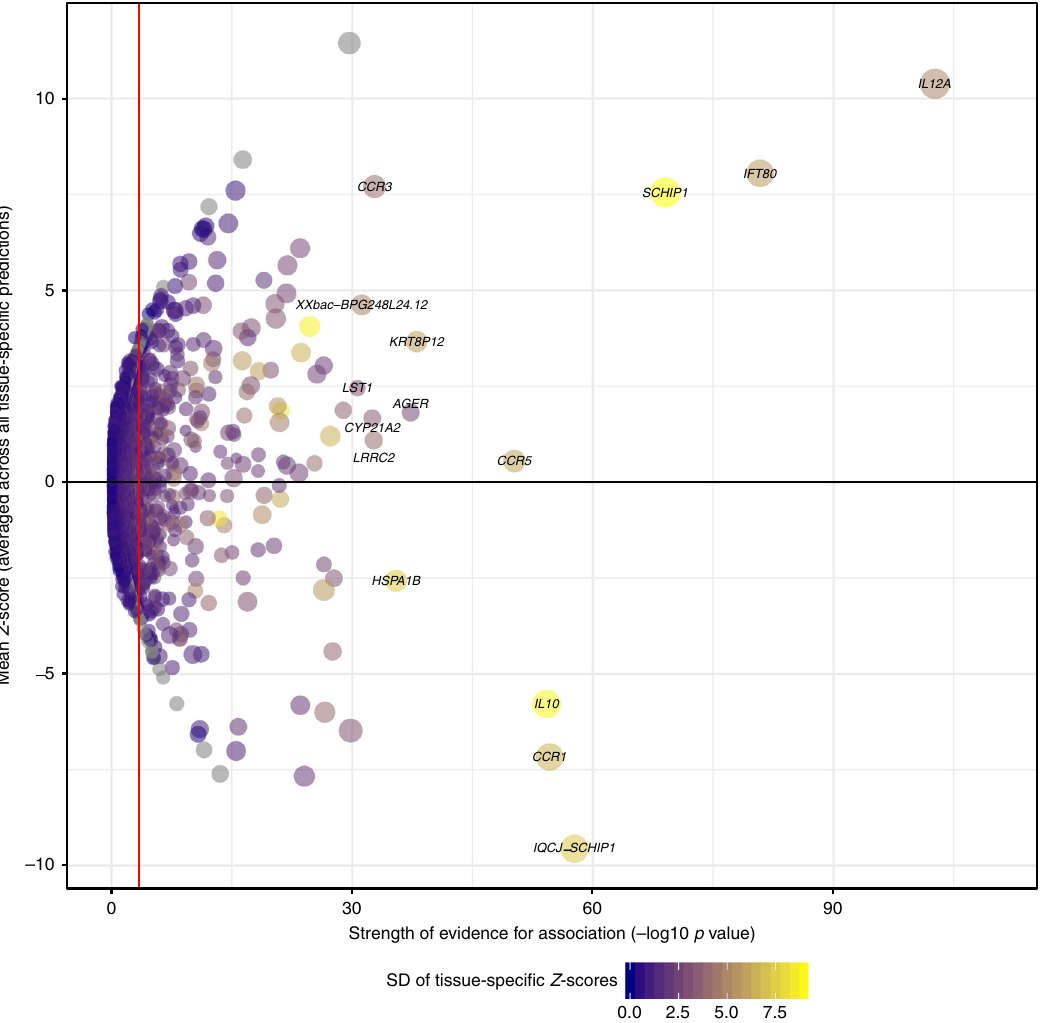
Fig. 3 Effect of predicted increased transcription of all genes on mouth ulcers. Each dot represented the effect of increased transcription (averaged across all tissue-speci fi c predictions using MultiXcan) on mouth ulcers. The size of the dot indicates the largest effect size in any tissue. The standard deviation (SD) of tissue-speci fi c Z -score is an indicator of tissue speci fi city with high values (yellow) indicating higher tissue speci fi